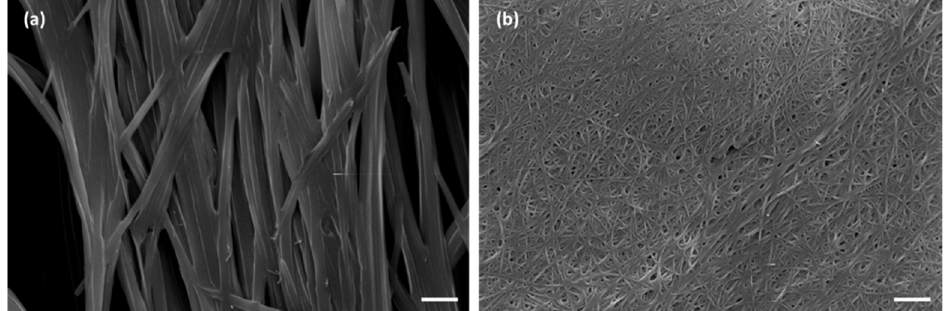
Figure 4. Scanning electron microscope (SEM) images of dried hydrogels ( a ) 1 and ( b ) 4 (scale bar: 5 µm).